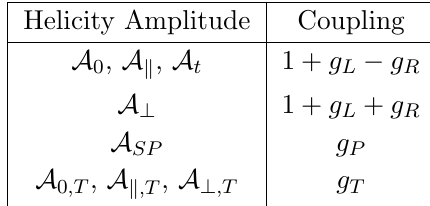
Table 3 . Contributions of N I CP-violating.